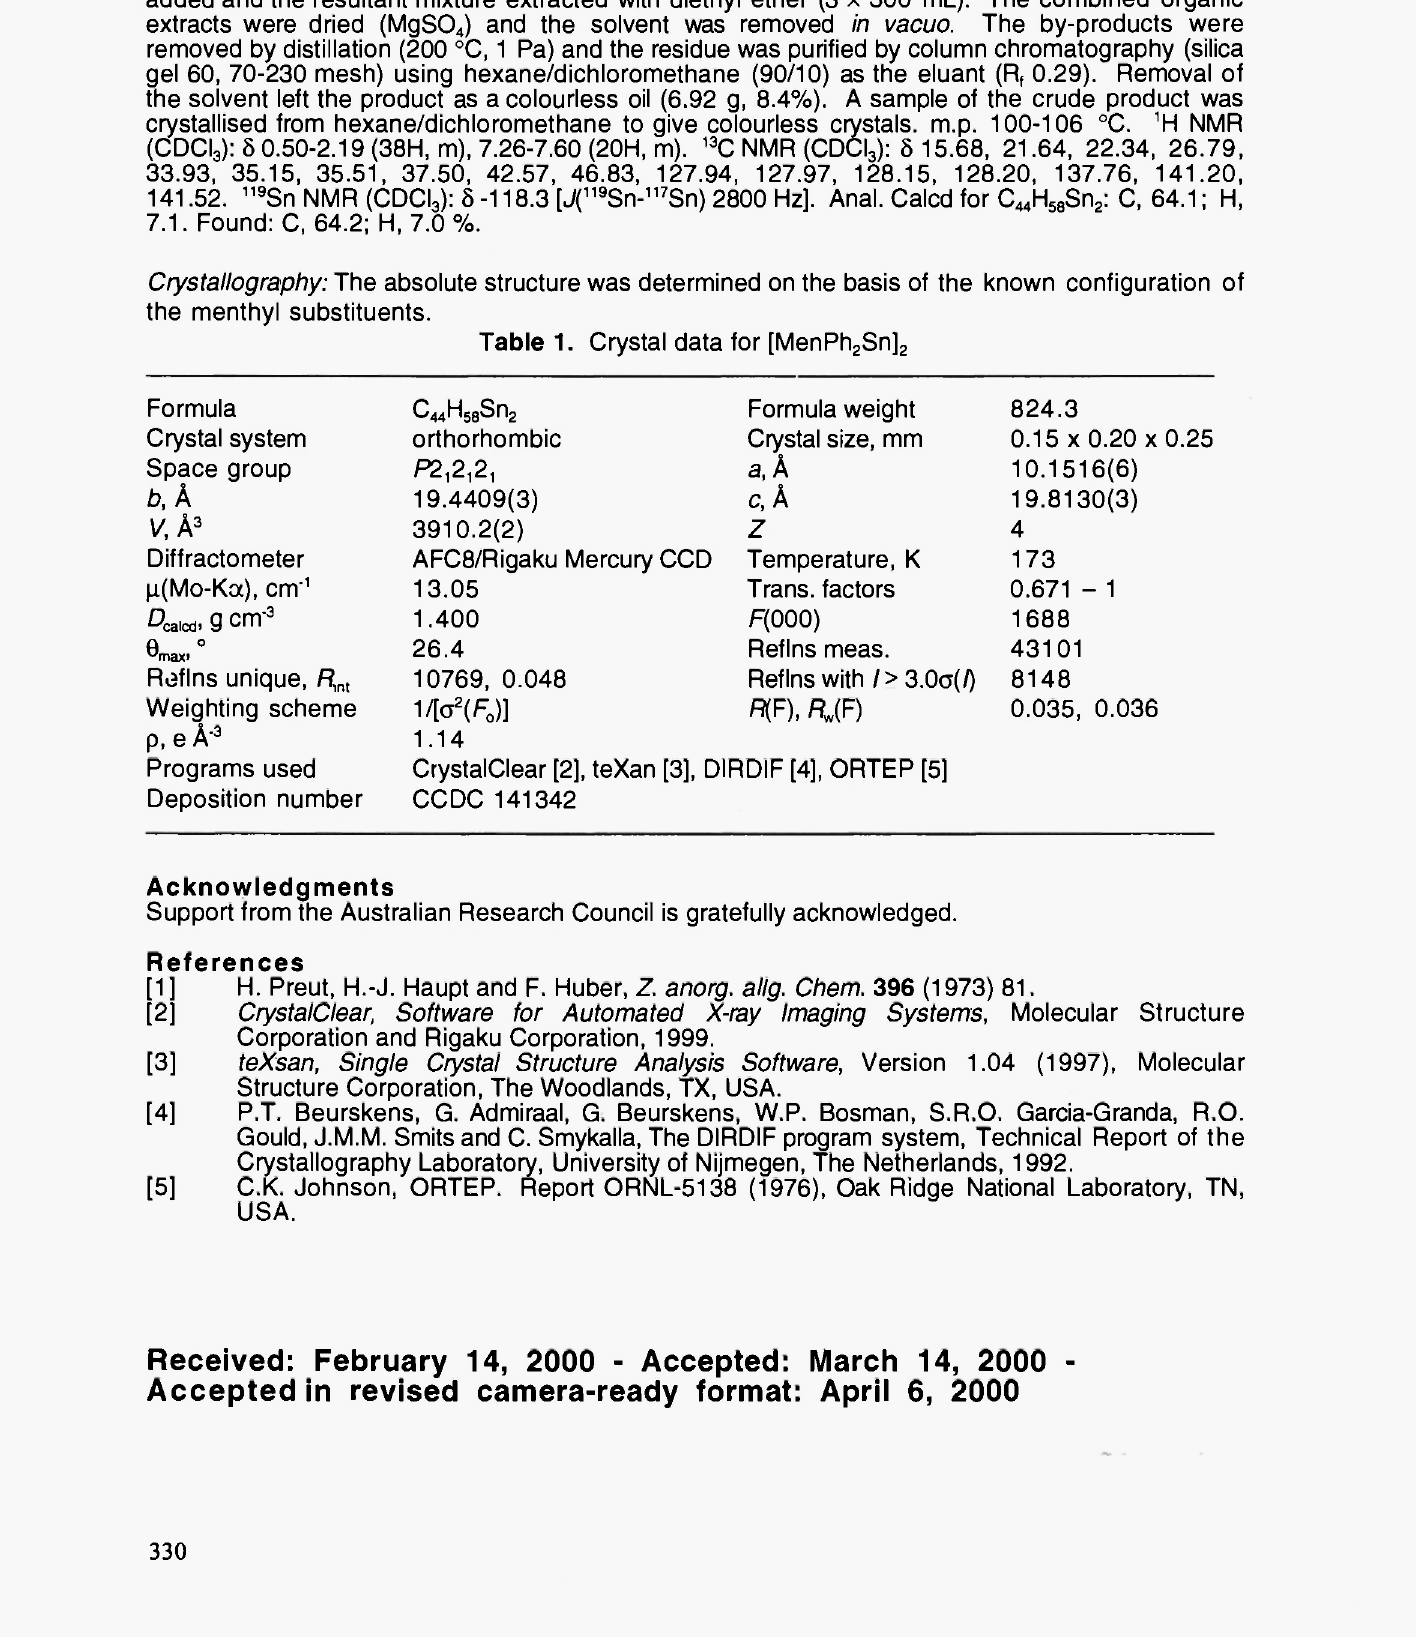
Table 1. Crystal data for [MenPh 2 Sn]